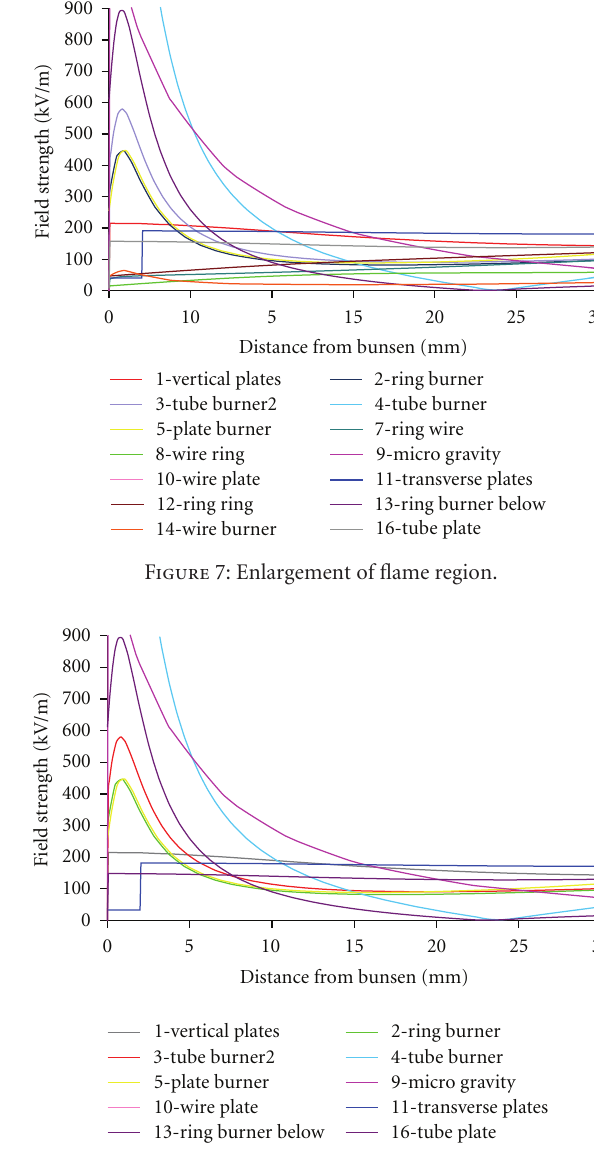
Figure 8: Enlargement of flame region with selected data